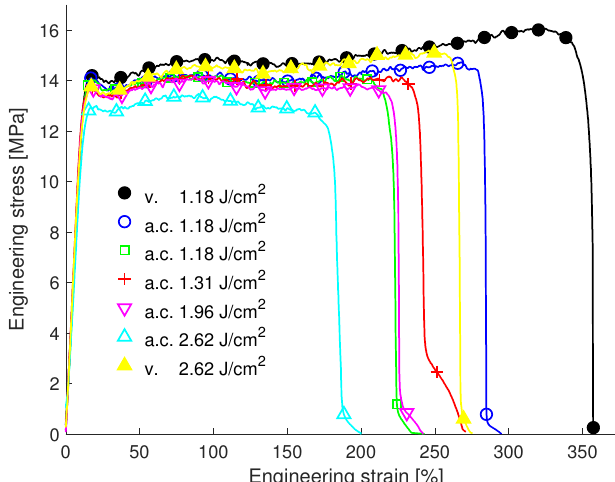
Figure 10. Influence of the ambient processing conditions on the tensile experiments of FEP VDA. For each condition, except the standard processing condition (vacuum (v.) and 1.18 J/cm 2 ), one sample was tested. Processing under atmospheric conditions (a.c.) shows a somewhat smaller UTS and a significant reduction of the ultimate tensile strain compared to vacuum conditions. This effect increases with increasing fluence